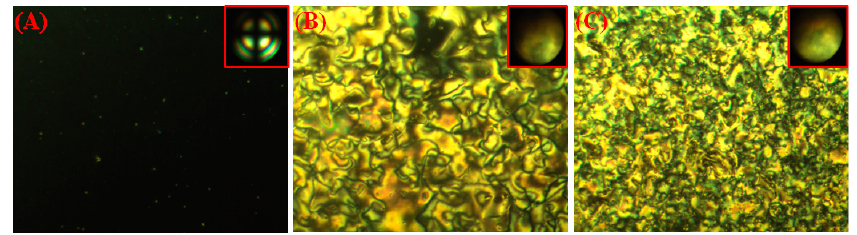
Figure 4. POM microphotographs of LC cells comprising BTDA-DMMDA PI film ( A ), polyimide based on 3,3 ′ ,4,4 ′ -benzophenonetetracarboxylic dianhydride and 4,4-diaminodiphenyl ether (BTDA-ODA PI )film ( B ), and polyimide based on 4,4 (cid:48) -Oxydiphthalic anhydride and 4,4-diaminodiphenyl ether (ODPA-ODA PI) film ( C ) with 1 wt % DA monomers after UV irradiation.